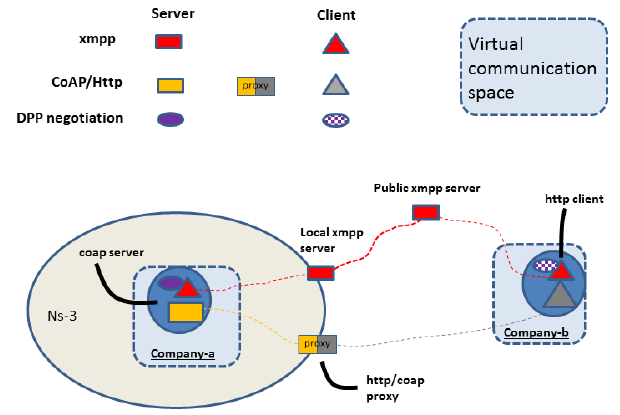
Figure 23. Data plane negotiation in the hypertext transfer protocol (HTTP) / constrained application protocol (CoAP) case.